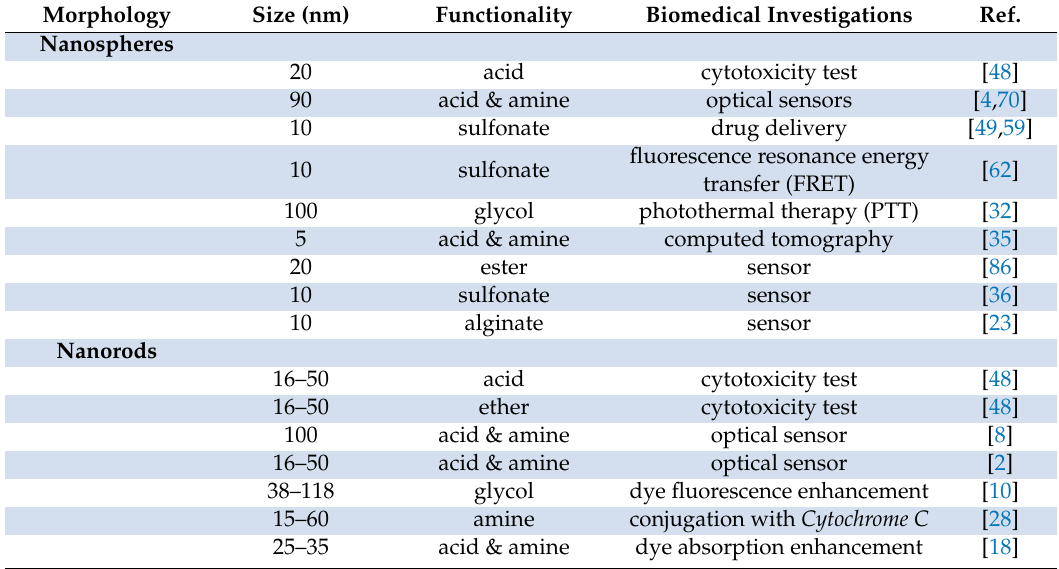
Table 1. Morphologies, dimensions, and functionalities of selected gold nanomaterials used in several biomedical